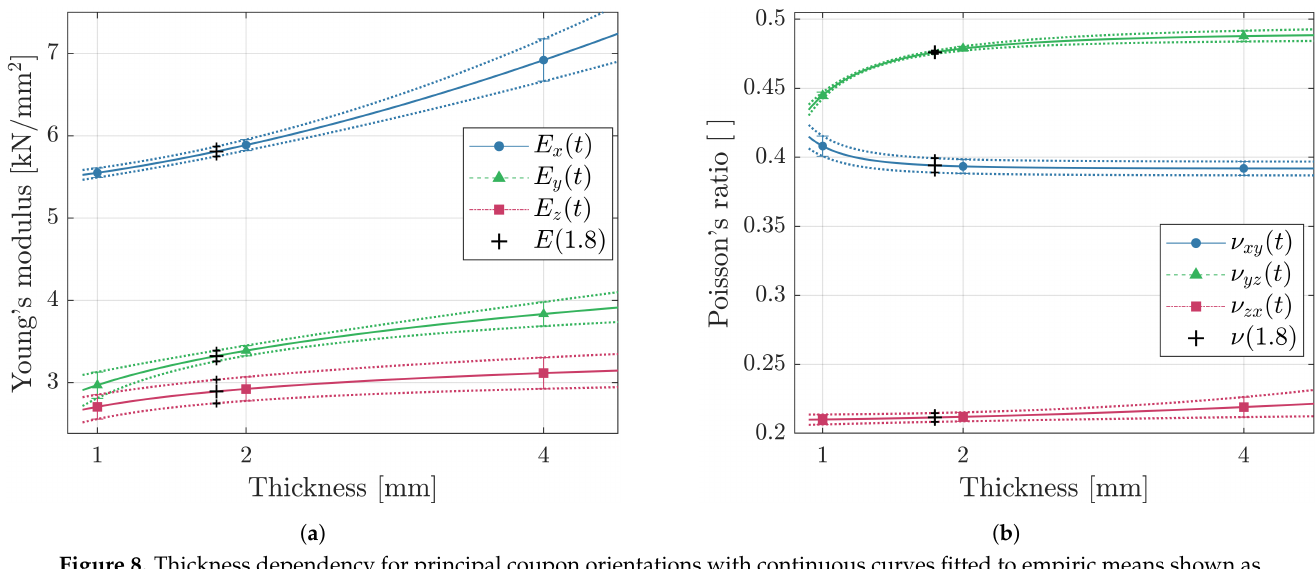
Figure 8. Thickness dependency for principal coupon orientations with continuous curves fitted to empiric means shown as markers as well as dotted lines fitted to the upper and lower bounds of the standard deviations indicated by the error bars for ( a ) Young’s modulus and ( b ) Poisson’s